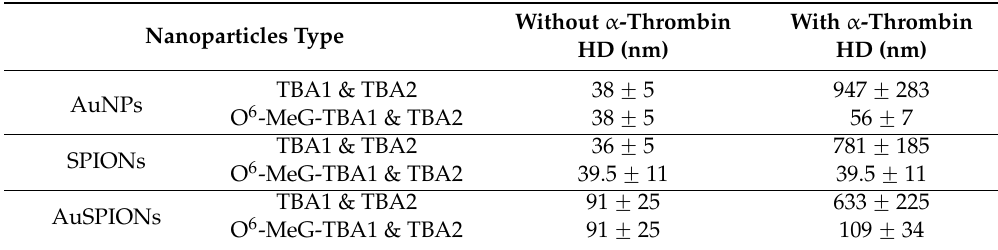
Figure 4. Particle size distribution of NPs-TBAs at 25 °C recorded by DLS. The mixtures of TBA1 and TBA2 NPs ( left ) and O 6 − MeG-TBA1 and TBA2 NPs ( right ) are displayed in dashed blue, while the same NP mixtures in the presence of α -thrombin are represented in orange. Each image is the result of the combination of two DLS experiments with and without α -thrombin. The individual DLS measurements are shown in Figure S4 (ESI). In all cases, the molar ratio of α -thrombin: TBAs was 0.5:1. From top to bottom: ( a ) AuNP, ( b ) SPIONs and ( c ) AuSPION. Table 2. Size distribution (HD, nm) by DLS of TBAs nanoparticles in the absence and in the presence of α -thrombin.